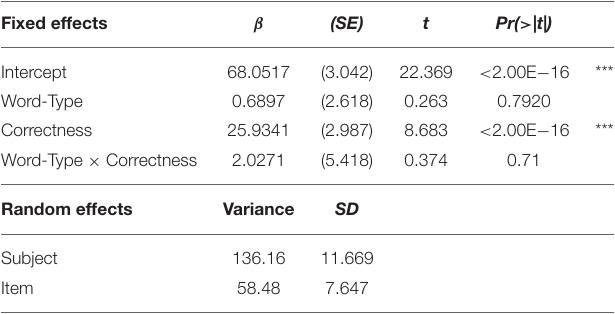
TABLE 8 | L1 meaning sureness LMER